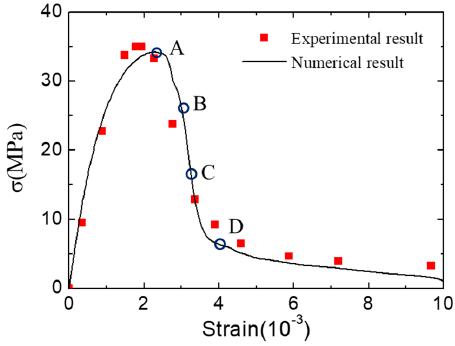
Figure 9. Average stress–strain curve of concrete under uniaxial compression in low-friction (LF) condition.